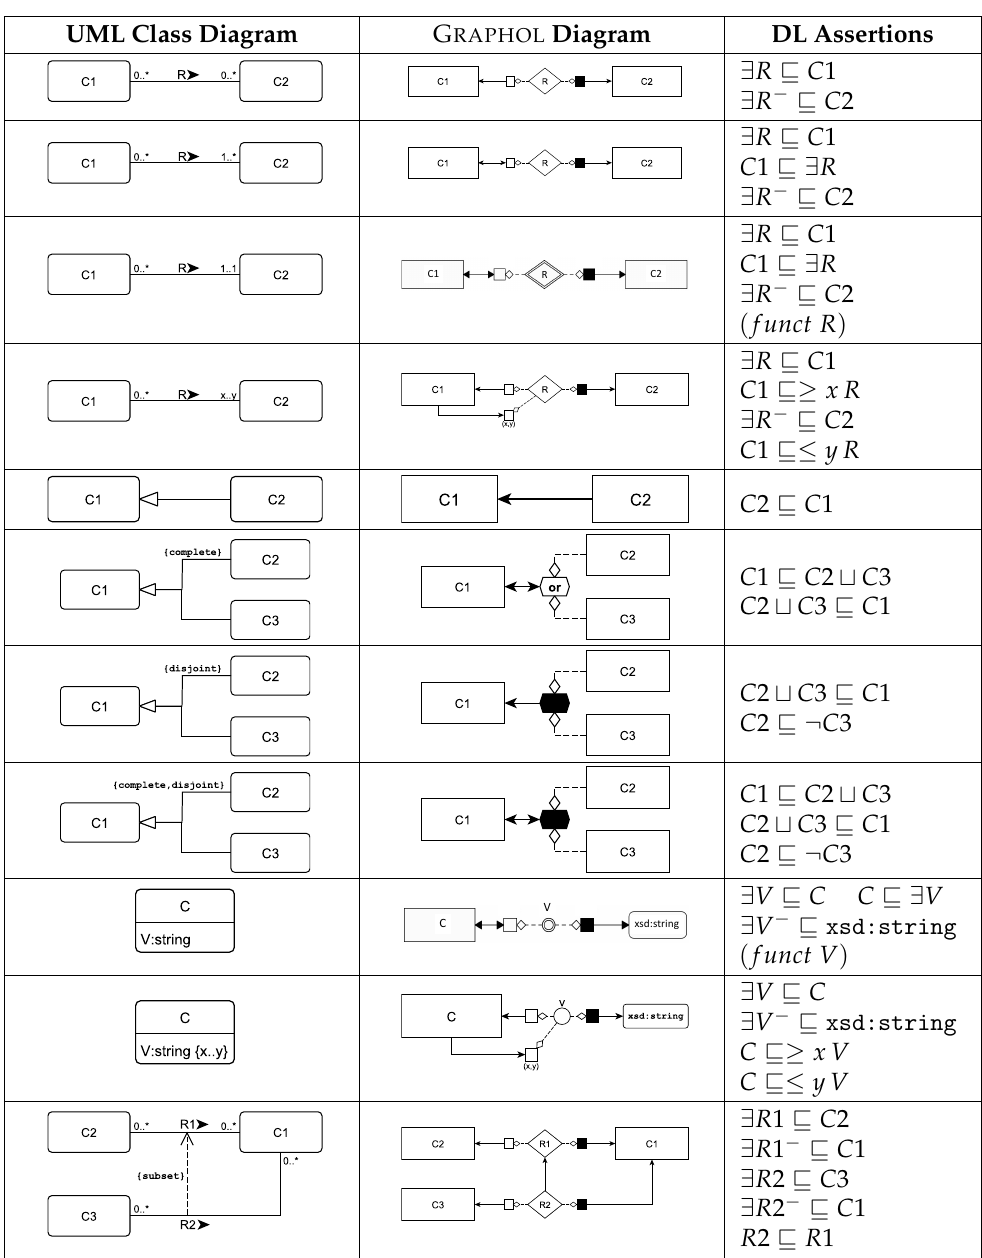
Figure 7. UML constructs, G RAPHOL corresponding diagrams, and related DL